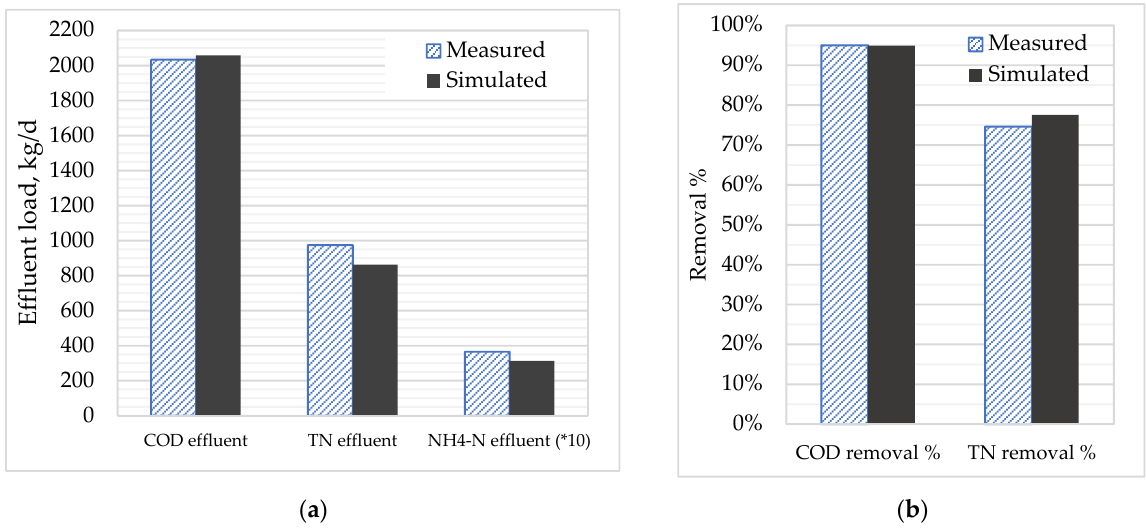
Figure 6. ( a ) Effluent load comparison between measured (blue) and simulated values (black); ( b ) COD and TN removal comparison between measured (blue) and simulated values (black).